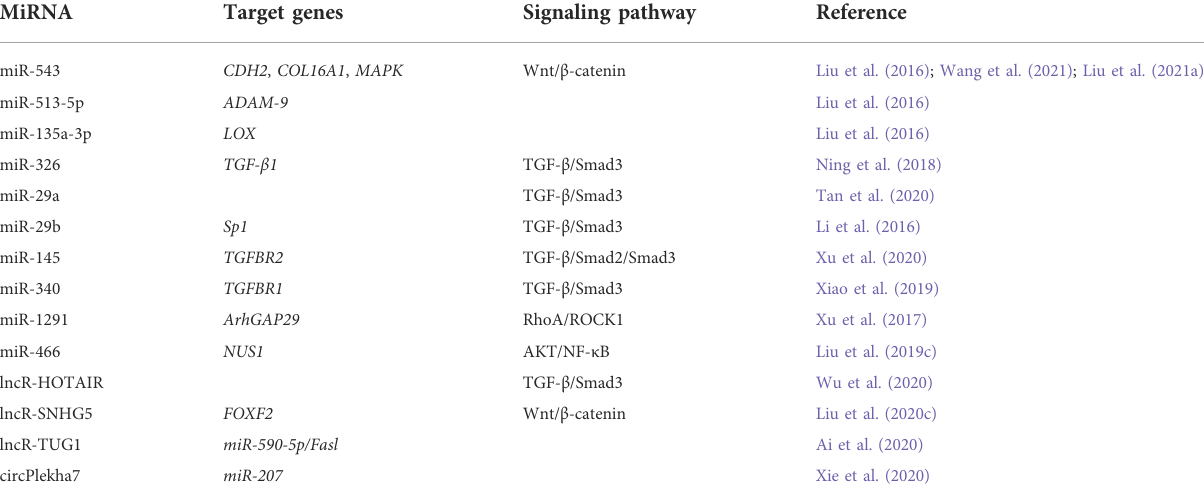
TABLE 1 ncRNAs involved in IUA pathophysiology. MiRNA Target